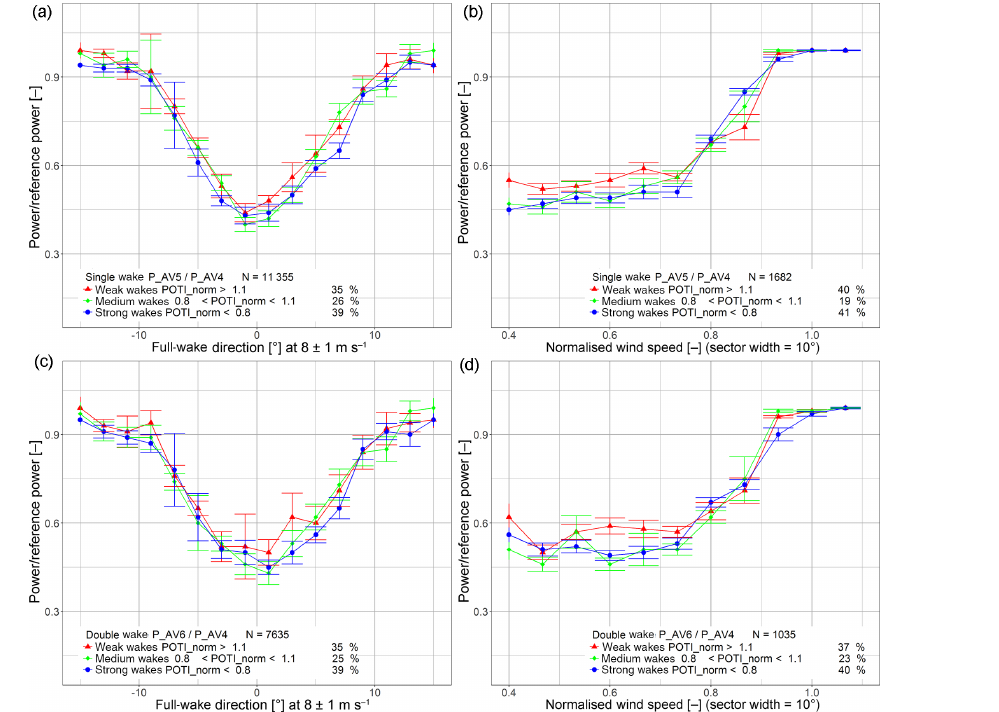
value. Power of waked turbine normalised with free-flow turbine. Upper row: single Figure 15. Stability classification with the PO TI norm wake, bottom row: double wake. Left column: normalised power as a function of wind direction, right column: normalised power as a function of wind